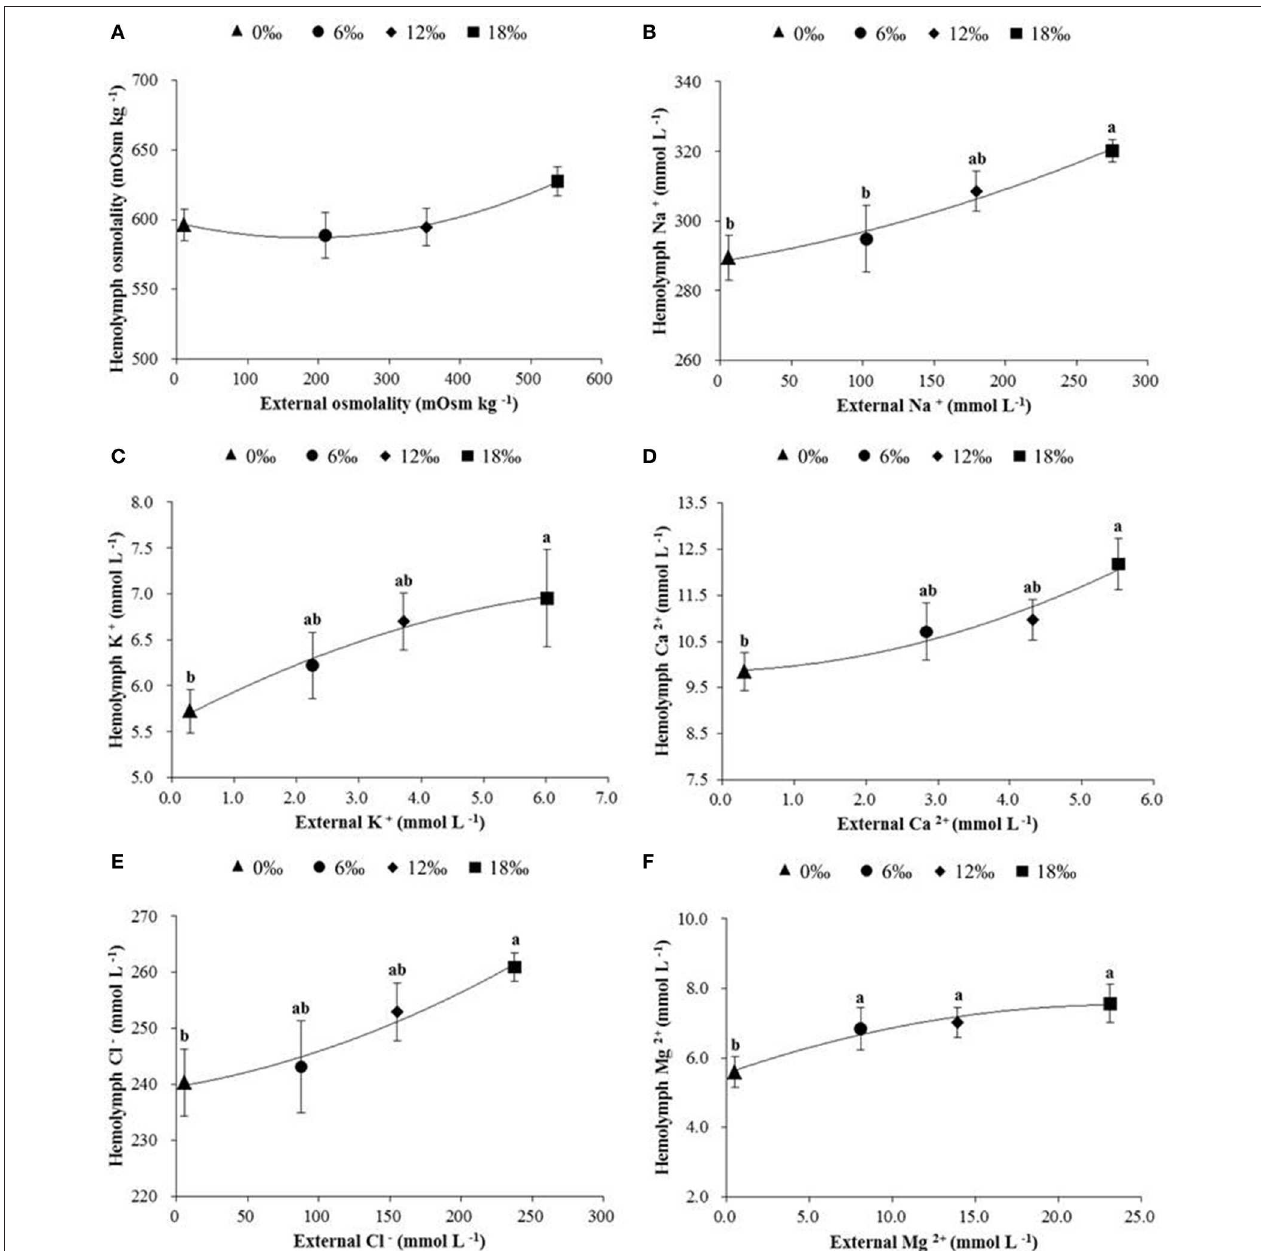
FIGURE 4 | The haemolymph osmolality (mOsm kg − 1 ) ( ± SE) (A) , and concentrations (m mol L − 1 ) of major ions ( B : Na + , C : K + , D : Ca 2 + , E : Cl − , and F : Mg 2 + ) in haemolymph of the female E. sinensis subjected to different salinities. Different letters indicated significant